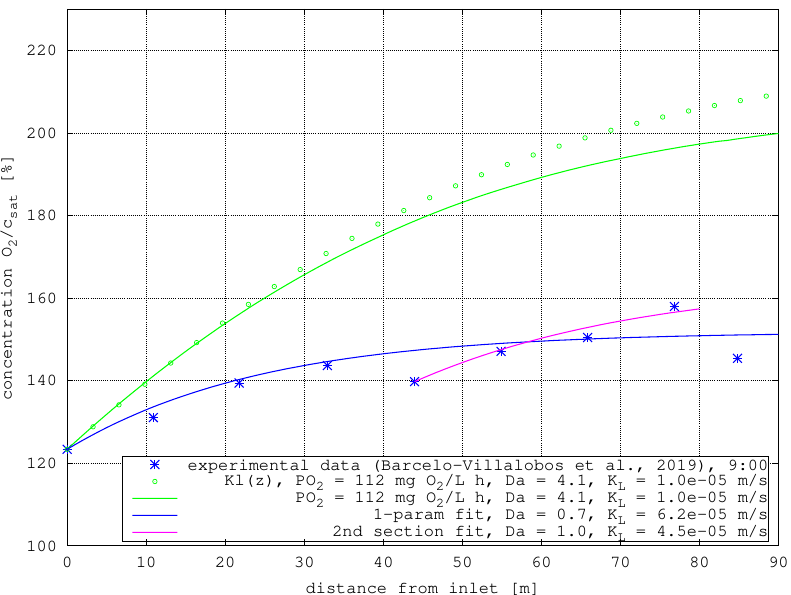
Figure 5. Experimental data describing the concentration profiles of dissolved oxygen along the thin-layer reactor [11], and curves based on the solution of Equation (7) with corresponding values of mass transfer coefficient K L . The top-most green data points represent the impact of local dependency of the mass transfer coefficient described by Equation